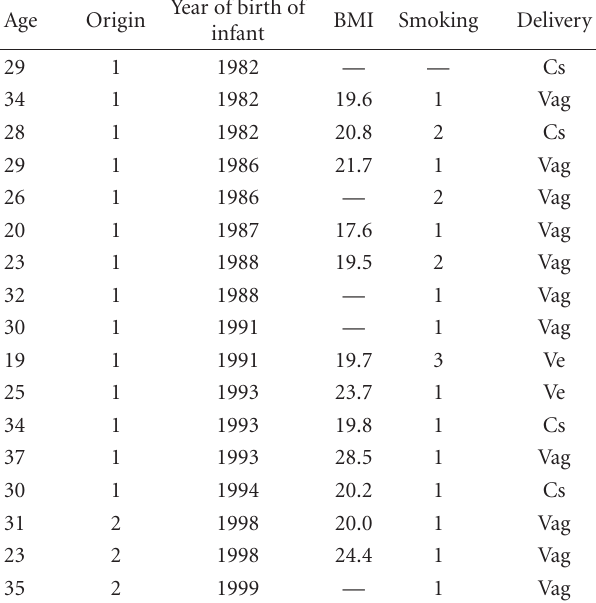
Table 1: Maternal characteristics: maternal country of birth: 1: Sweden, 2: Mediterranean countries. Year of birth of infant with neuronal migration disorder. BMI: weight in kg/length in